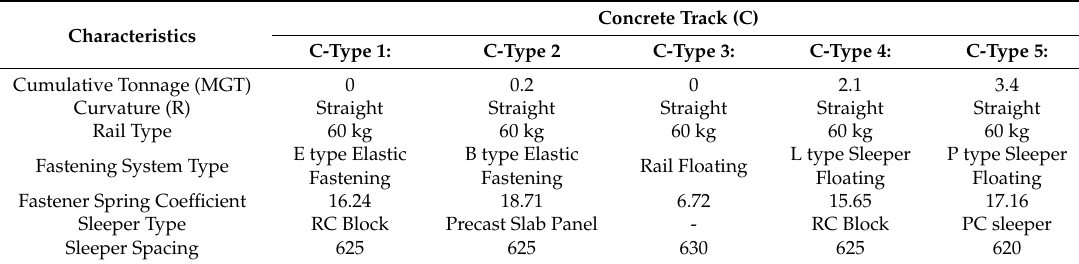
Table 3. Track specifications (concrete tracks) .